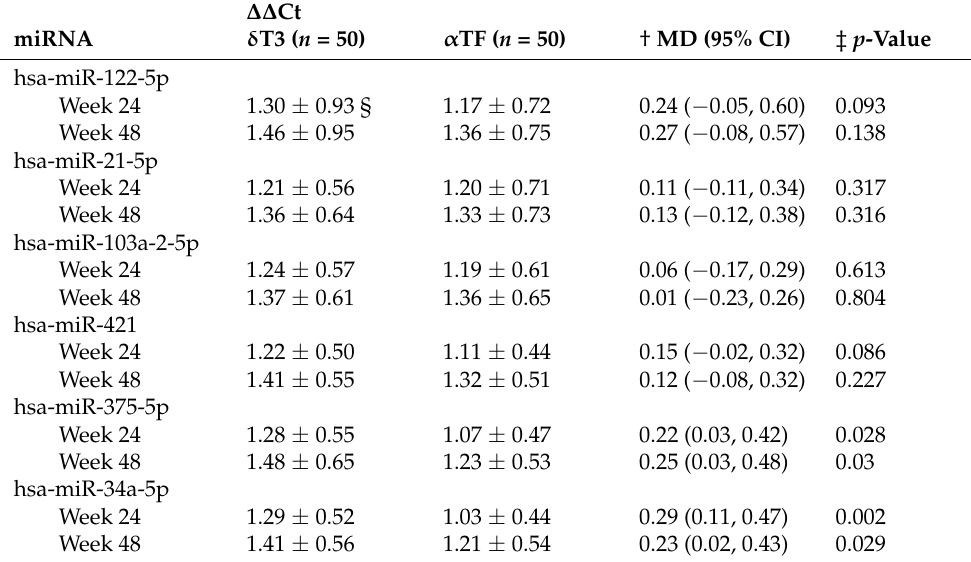
Table 2. Mean changes in miRNA expression from baseline to 24 and 48 weeks. ∆∆